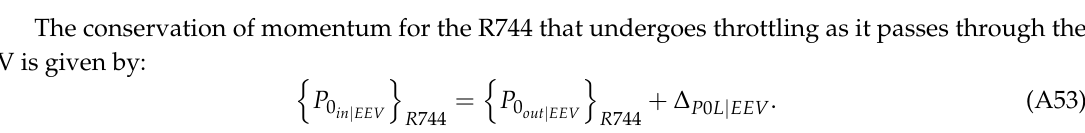
Figure A6. Refrigerant mass flow rate as a function of EV opening.